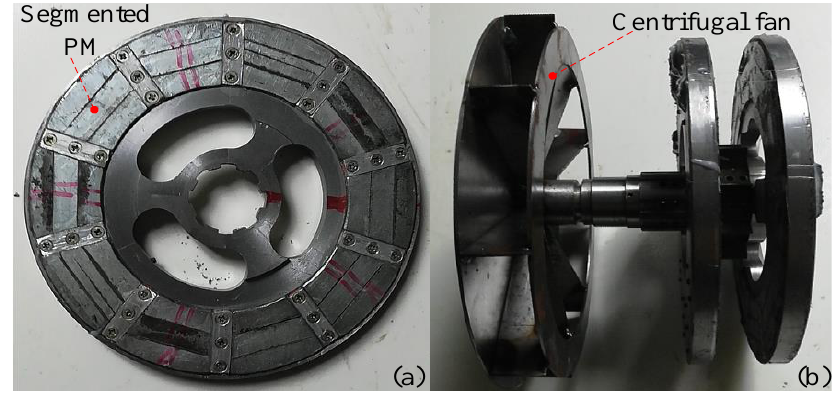
Figure 24. Rotor component ( a ) single rotor, ( b ) two rotors with centrifugal fan.